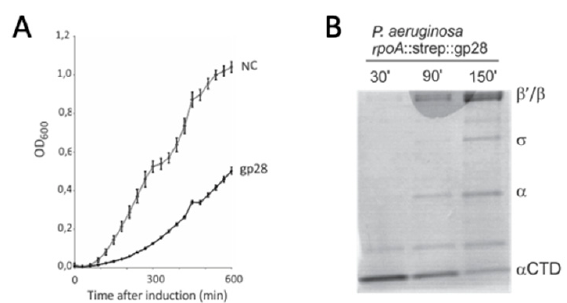
Figure A2. Reversion of the cleaved phenotype upon prolonged incubation. ( A ) Wildtype P. aeruginosa PAO1 rpoA::strep (NC) and P. aeruginosa PAO1 rpoA::strep,gp28 cells were grown overnight, diluted (1:50) in LB / 1 mM IPTG, and growth was followed spectrometrically. ( B ) Pull-down of the α RNAP subunit from 200 mL of P. aeruginosa PAO1 rpoA::strep,gp28 cells after 30, 90 and 150 min of incubation. Eluates were separated on 4–15% SDS-PAGE gels.